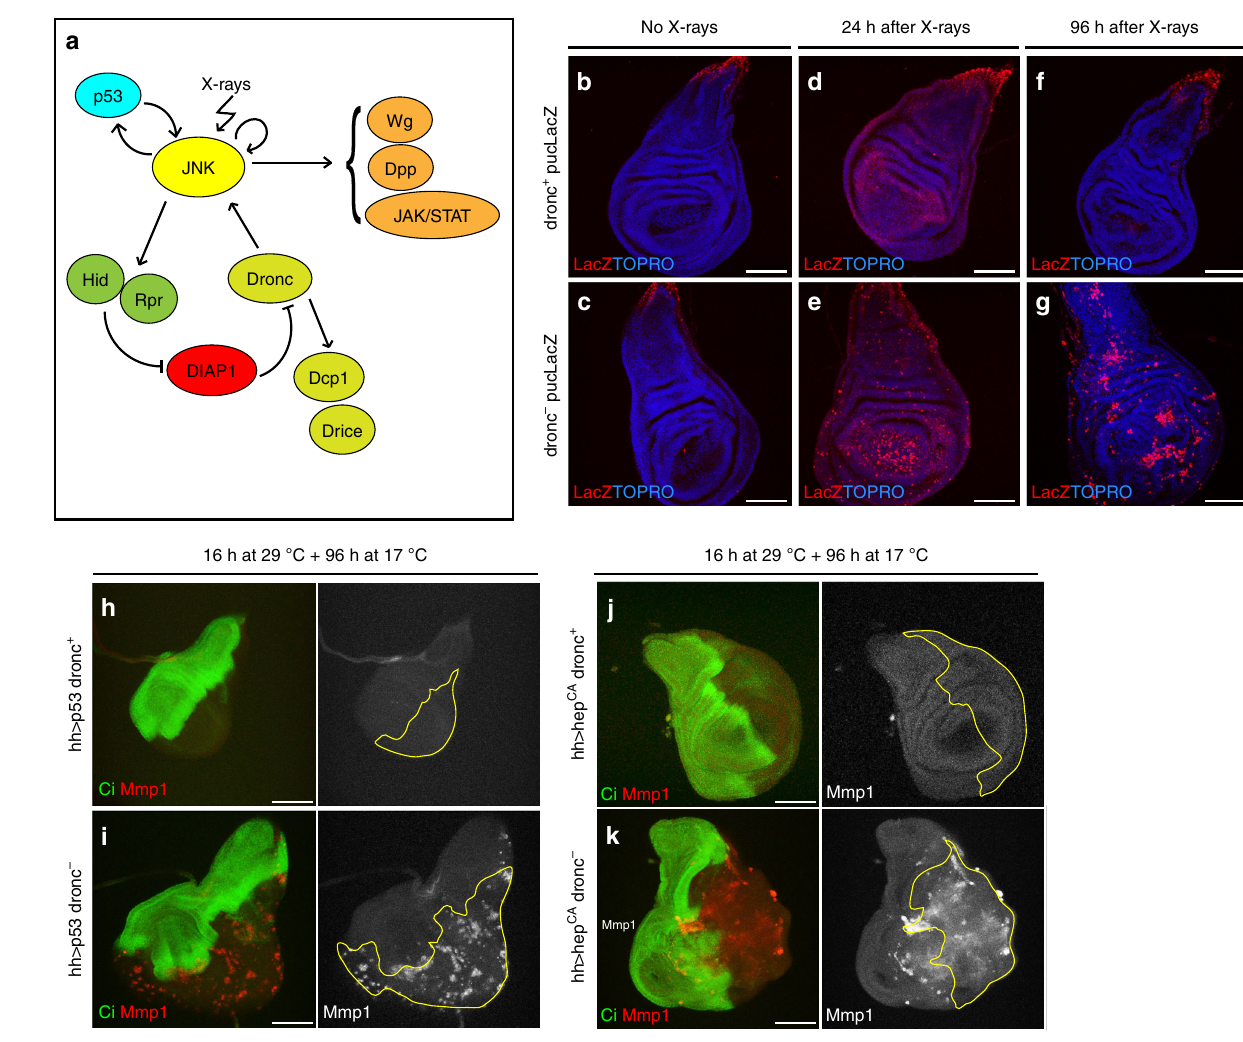
Fig. 1 JNK persistent activity after irradiation or a short pulse of p53 and JNK in apoptosis-de fi cient cells. a Simpli fi ed representation of the apoptotic pathway in Drosophila . JNK/p53 are activated after irradiation and induce the activation of the pro-apoptotic genes that block DIAP1, inducing the activation of the apical caspase Dronc and effector caspases Dcp1 and Drice. Besides, Dronc reinforces JNK activity generating an ampli fi cation loop that augments the apoptotic response 26 . As a side event, JNK activates the Dpp, Wg and JAK/STAT pathways. b-g Wing discs showing the effects of X-rays at different time points. JNK activity is monitored by the expression of a LacZ insert at the JNK target puckered ( puc , red). The blue background re fl ects TOPRO staining. b , c puc expression in non-irradiated dronc + control ( n = 10) and null dronc − mutant ( n = 17) discs. Note that the label is restricted in both cases to a small region that corresponds to the most proximal zone of the disc. d , e Twenty-four hours after irradiation, both dronc + ( n = 22) and dronc − ( n = 18) discs show high expression levels of puc , especially in the region corresponding to the wing pouch. f , g puc expression 96 h after irradiation in dronc + ( n = 28) and dronc − ( n = 31) discs. Whereas puc levels have returned to normal in dronc + ( f ), they remain high in many zones of the dronc − discs ( g ). Wing discs of genotype: h UAS-p53/UAS-GFPtubGal80 ts ; hh-Gal4dronc i29 / + ( n = 10), i UAS-p53/UAS-GFPtubGal80 ts ;hh-Gal4dronc i29 /dronc i29 ( n = 14), j UAS-hep CA /UAS- GFPtubGal80 ts ;hhGal4dronc i29 / + ( n = 10) and k UAS-hep CA /UAS-GFPtubGal80 ts ;hh-Gal4dronc i29 /dronc i24 ( n = 11). Discs are stained with Cubitus interruptus , Ci (green) to mark the anterior compartment and Mmp1 (red) to monitor JNK activity. The short pulse of p53 ( h , i ) or of hep CA ( j , k ), at the posterior compartment is administered by temperature shift, detailed in Methods section; 96 h after the change to 17 °C, no activity of JNK can be detected by Mmp1 staining (red) in the posterior compartment (lack of green) in p53 dronc + ( h ) and hep CA dronc + discs ( j ). In contrast, there is JNK activity (red) at the posterior compartment (lack of green) of p53 dronc − ( i ) and in hep CA dronc − discs ( k ). Scale bars are 100 μ causes constitutive activity of the pathway. In control discs, in which apoptosis is not prevented, the brief expression of JNK (Supplementary Fig. 1h) rapidly subsides (Fig. 1h, j).